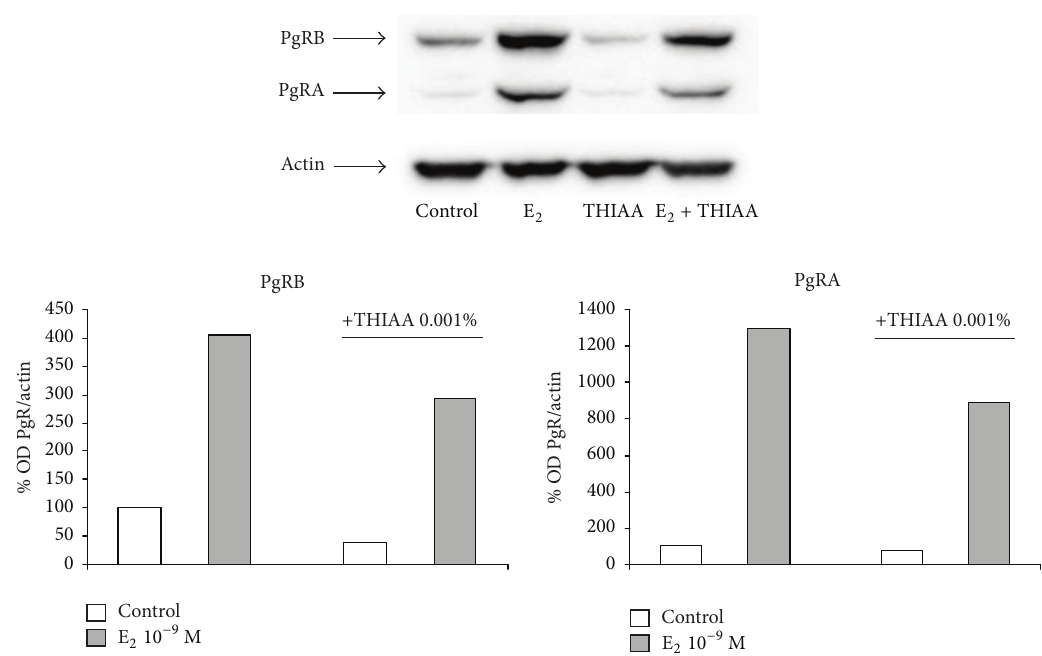
Figure 8: Effect of THIAA on PgR expression in steroid-free culture medium by western blot. MCF-7 cells were incubated for 24 h in the absence (control) or presence of E 2 at 10 −9 M with or without THIAA at 0.001%. Immunoblots and optical density (OD) analyses of PgRA and PgRB refer to an experiment performed independently twice. ODs of both PgR isoforms are normalized by ODs of actin and expressed as percentage of control.